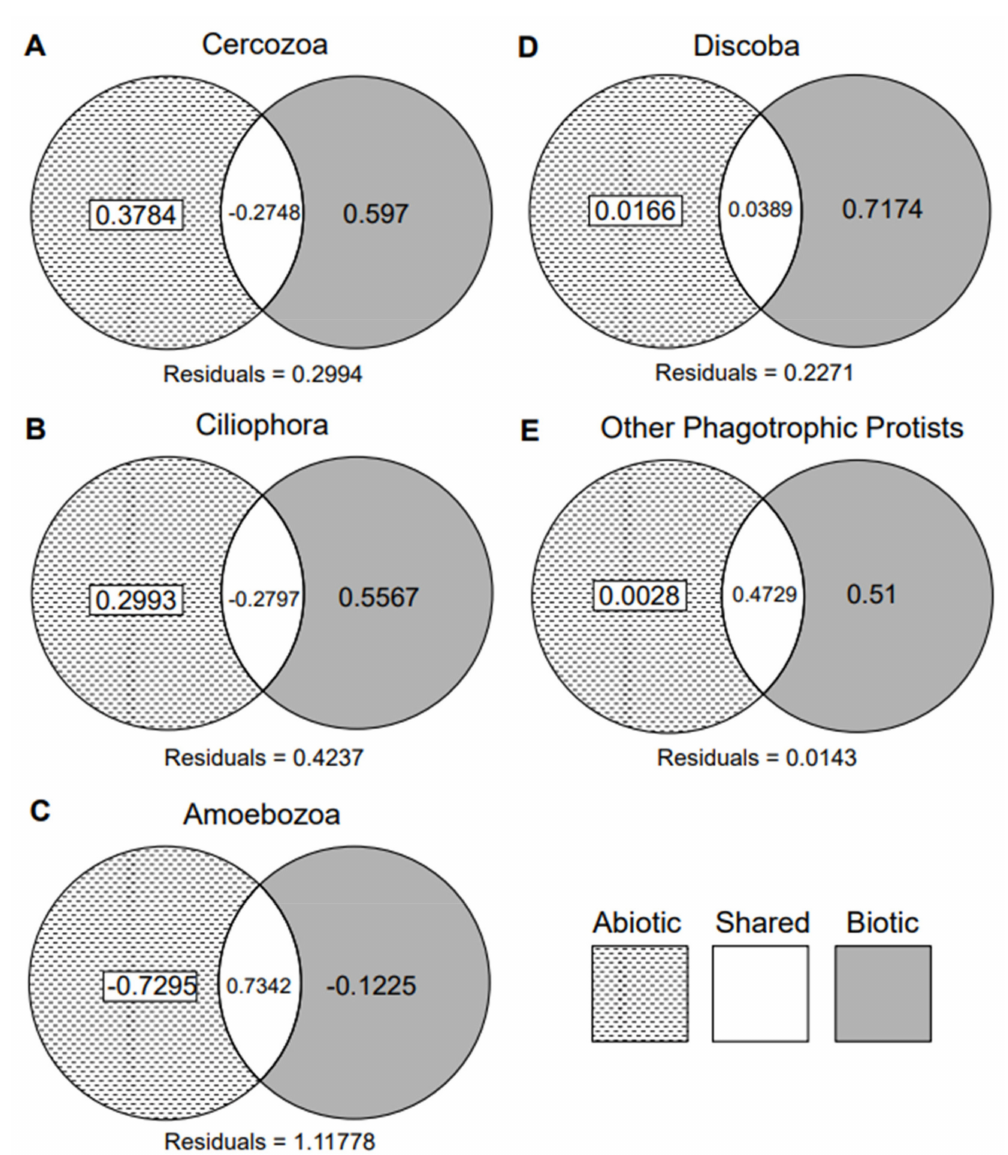
Figure 1. Phagotrophic protists are structured more by biotic factors rather than abiotic factors. Variation partitioning for five phagotrophic protist groups with all biota as biotic component, and environmental variables as abiotic component. Adjusted R 2 values are shown inside each Venn diagram component (abiotic, shared, and biotic) and for the residual. Variation partitioning for ( A ) Cercozoa, ( B ) Ciliophora, ( C ) Amoebozoa, ( D ) Discoba, and ( E ) other phagotrophic